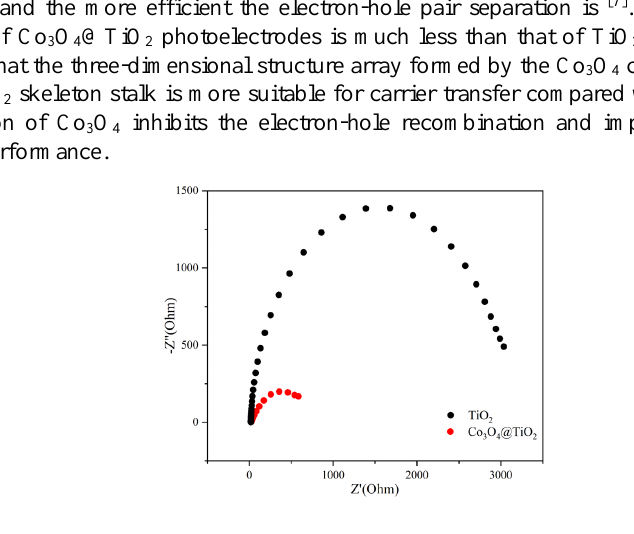
Fig. 4. EIS plots for TiO 2 and Co 3 O 4 @TiO 2